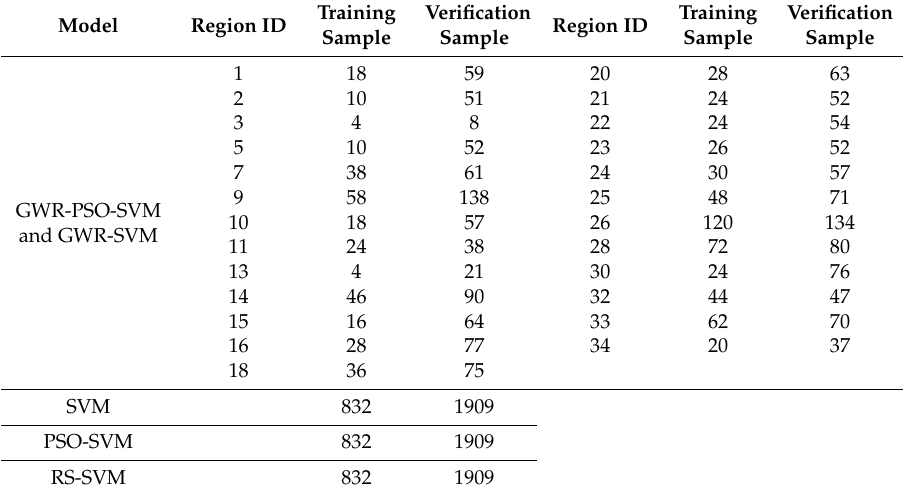
Table 9. The training and verification sample of the five